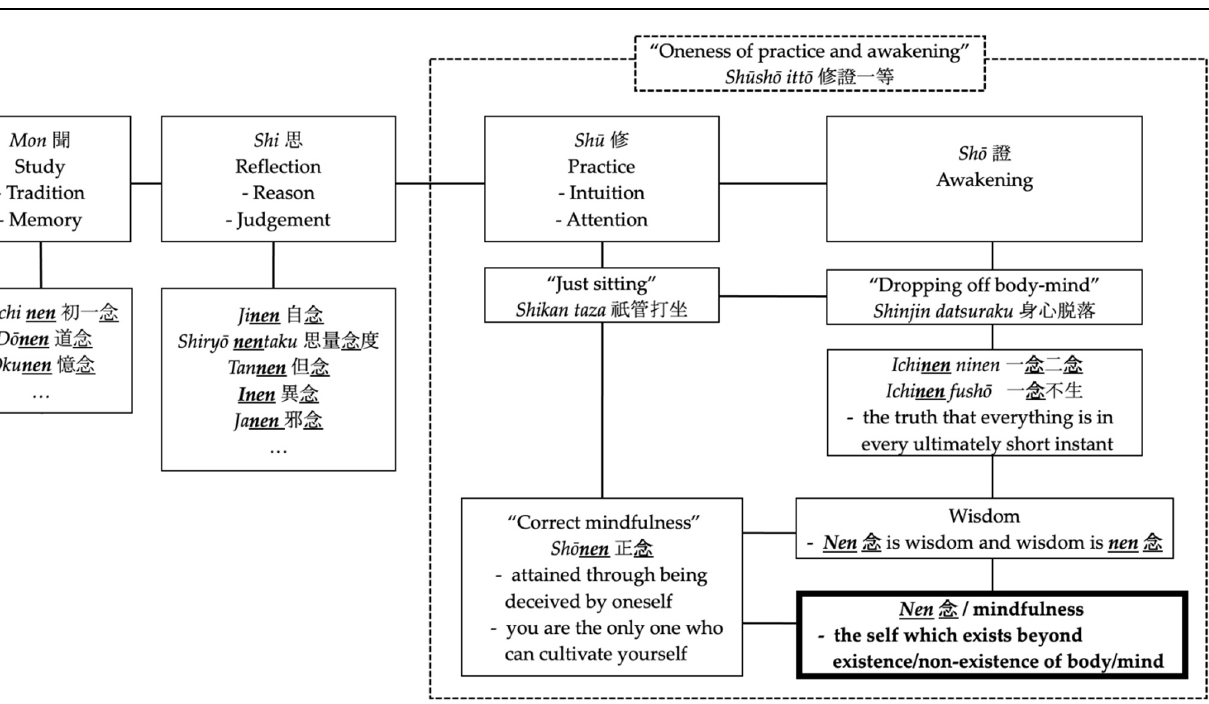
Figure 1. The overall picture of threefold wisdom, nen 念 , and key concepts in SBGZ.